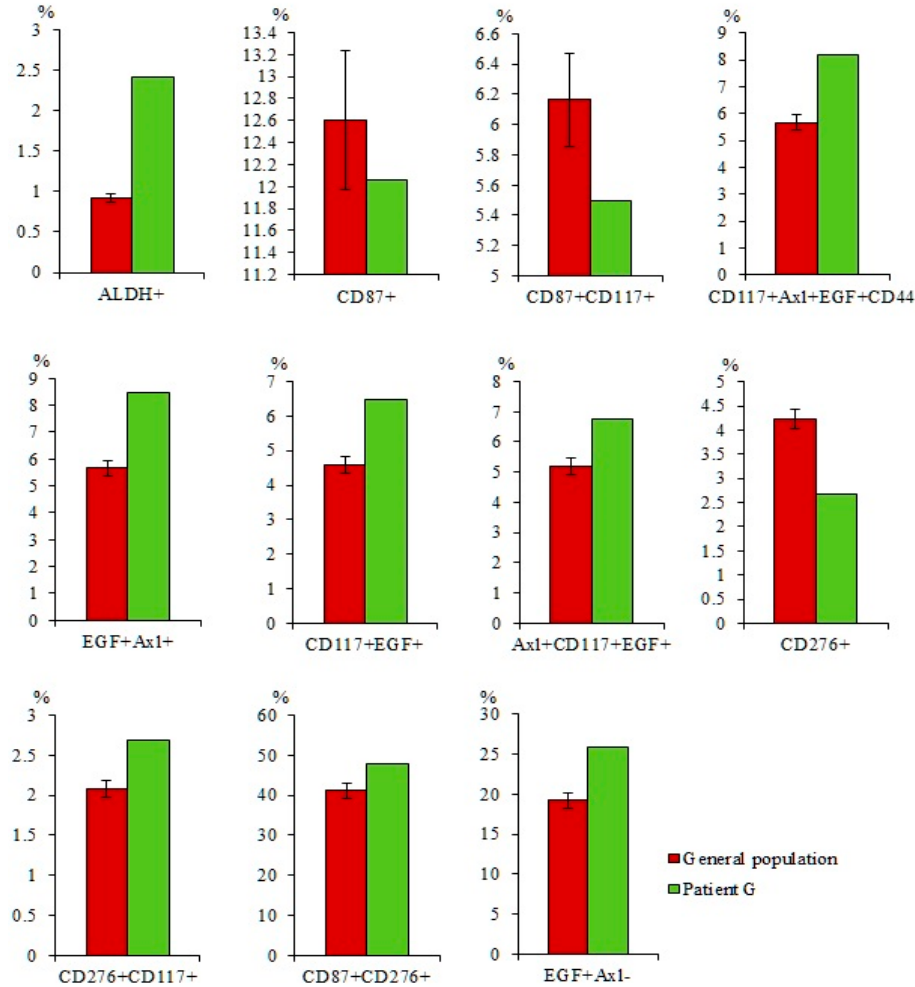
Figure 9. The content of CD87 + , CD87 + CD117 + , CD117 + Axl + EGF + CD44 + , EGF + Axl + , CD117 + EGF + , Axl + CD117 + EGF + , CD276 + , CD276 + CD117 + , CD87 + CD276 + , and EGF + Axl − circulating tumor cells (CTCs) in the blood of the general population SCLC patients and patient G (% of all labelled mononuclear cells). Cells were analyzed by flow cytometry using antibodies against CD44, CD87, CD117, CD276, EGF, and Axl.